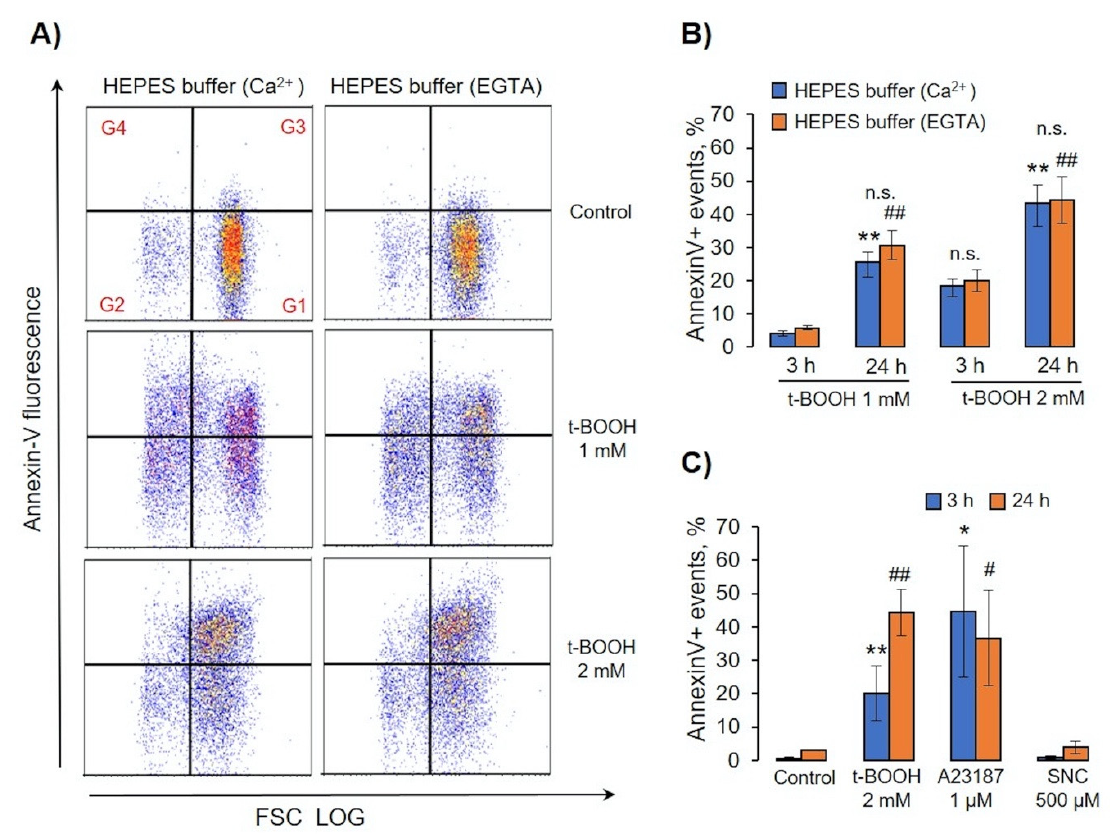
Figure 8. OS-induced annexin-V binding was calcium-independent. RBCs (0.5 × 10 9 cells / mL) were incubated with indicated concentrations of t-BOOH, A23187, and SNC in HEPES bu ff er containing 2 mM Ca 2 + or 2 mM EGTA for indicated times. Annexin-V (0.1 µ g / mL, 15 min, 25 ◦ C) was added to treated cells and analyzed by flow cytometry. ( A ) Representative annexin V / FSC dot plots of one out of six independent experiments for 24 h. Gate G1 corresponds to control cells; G2 to annexin-V-negative EVs; G3 to annexin-V-positive cells; G4, annexin-V-positive EVs. ( B,C ) Calculation of annexin-V-positive events in G3 and G4. Data in ( B – D ) are presented as the mean ± SD, in ( B )—paired t -test; ** p < 0.001, compared to 3h in HEPES bu ff er with Ca 2 + ; ## p < 0.001, compared to 3 h in HEPES bu ff er with EGTA; n.s.—not significant. In ( C )—one-way ANOVA, Levene’s test < 0.05, Tamhane’s T2 post hoc; * p < 0.05, ** p < 0.001, compared to 3 h control; # p < 0.05, ## p < 0.001, compared to 24 h control.